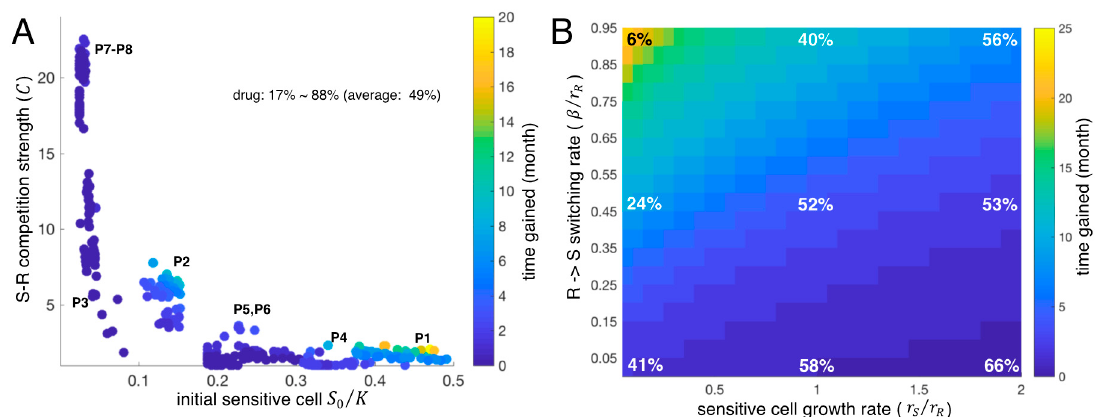
Figure 5. Adaptive therapy simulation with a 20% burden decrease as a stop-treatment criterion. ( A ) Average time gained in months with 20% adaptive therapy compared to continuous therapy (time to progression on 20% threshold adaptive therapy–time to progression on continuous therapy) predicted by the LV model as a function of initial sensitive cell proportion and S-R competition coefficient. ( B ) Average time gained predicted by the SW model as a function of sensitive cell growth rate and R → S transition rate. Percent represents the average dose rate relative to continuous therapy.